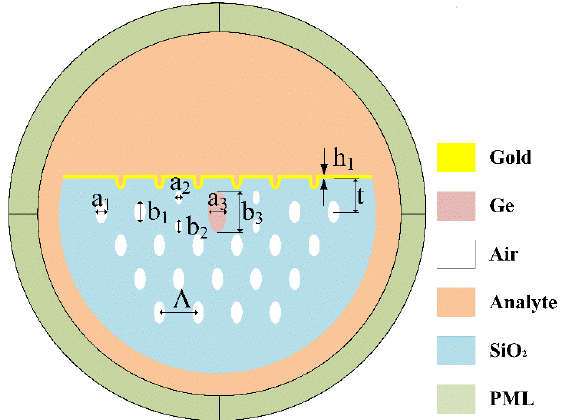
Figure 1. The D ‐ shaped PCF sensor model proposed in this paper. Figure 1. The D-shaped PCF sensor model proposed in this paper. The concentration of germanium is e; then, the RI of the germanium ‐ doped region of the ellipse is: